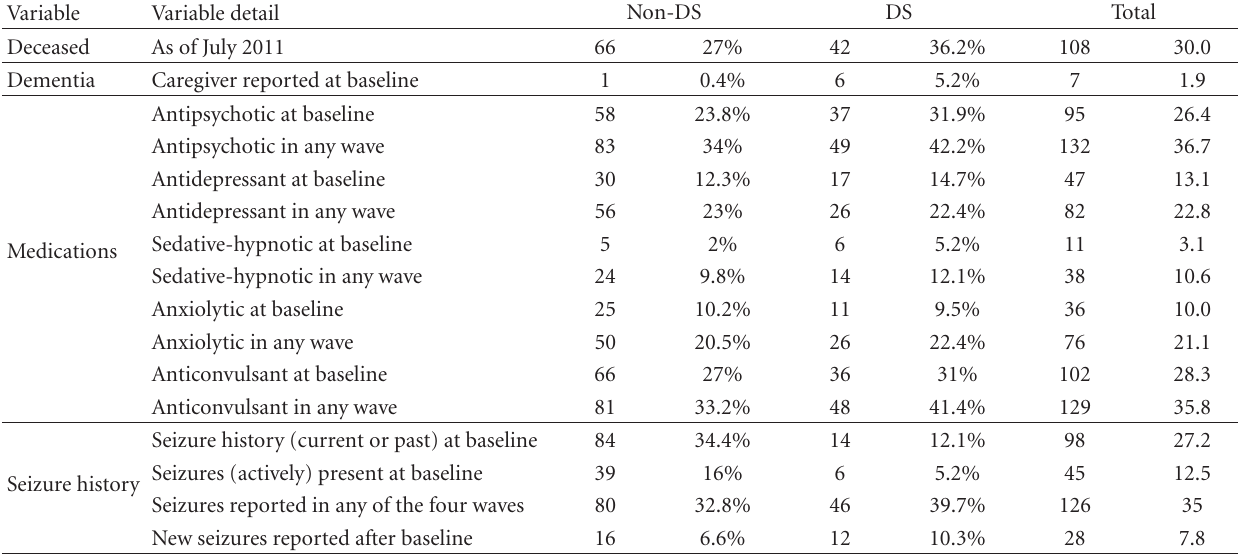
Table 2: Summary of key variables entered into the survival model (categorical